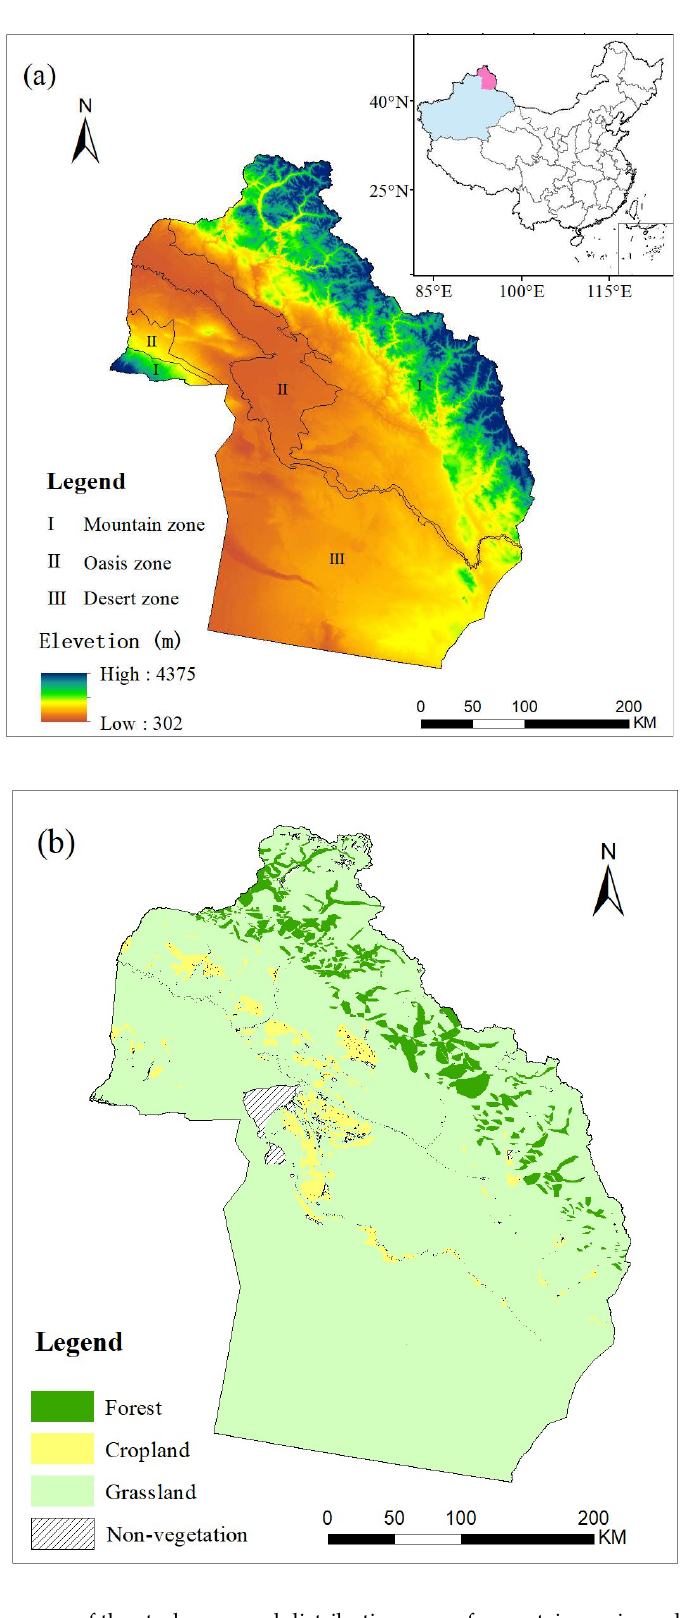
Figure 1. Location map of the study area and distribution map of mountain, oasis, and desert zones ( a ), distribution map of vegetation and nonvegetation in Altay Prefecture ( b